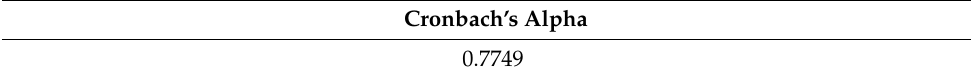
Table 6. Agile Cronbach’s value.